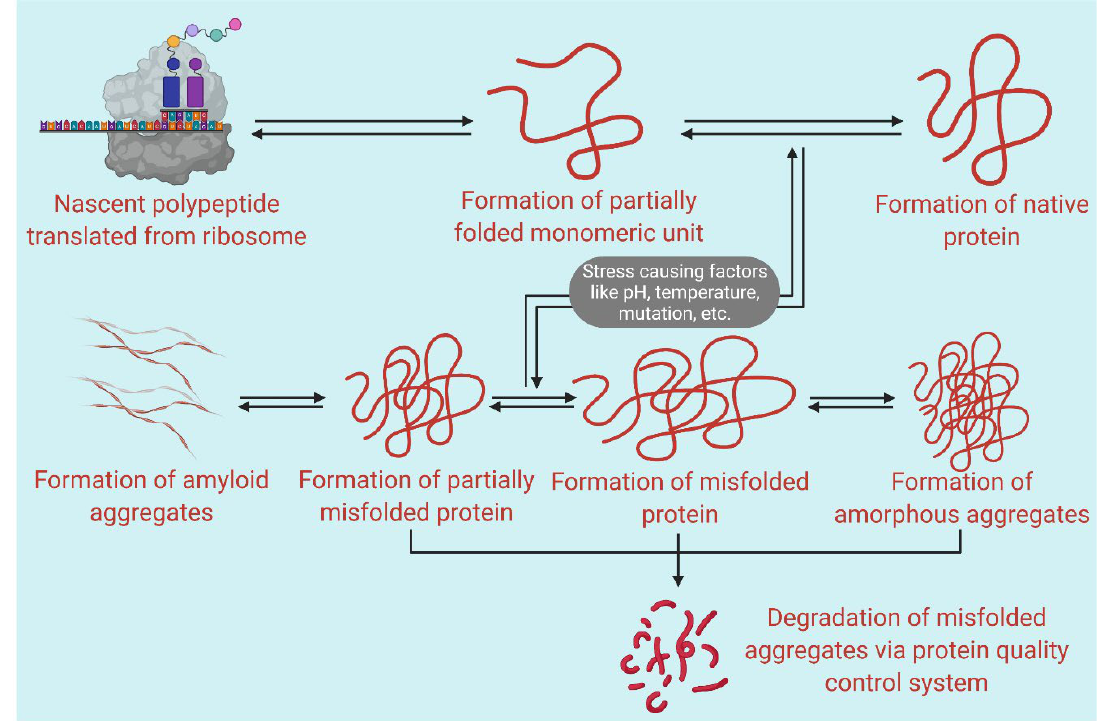
Figure 2: Mechanism of protein aggregation